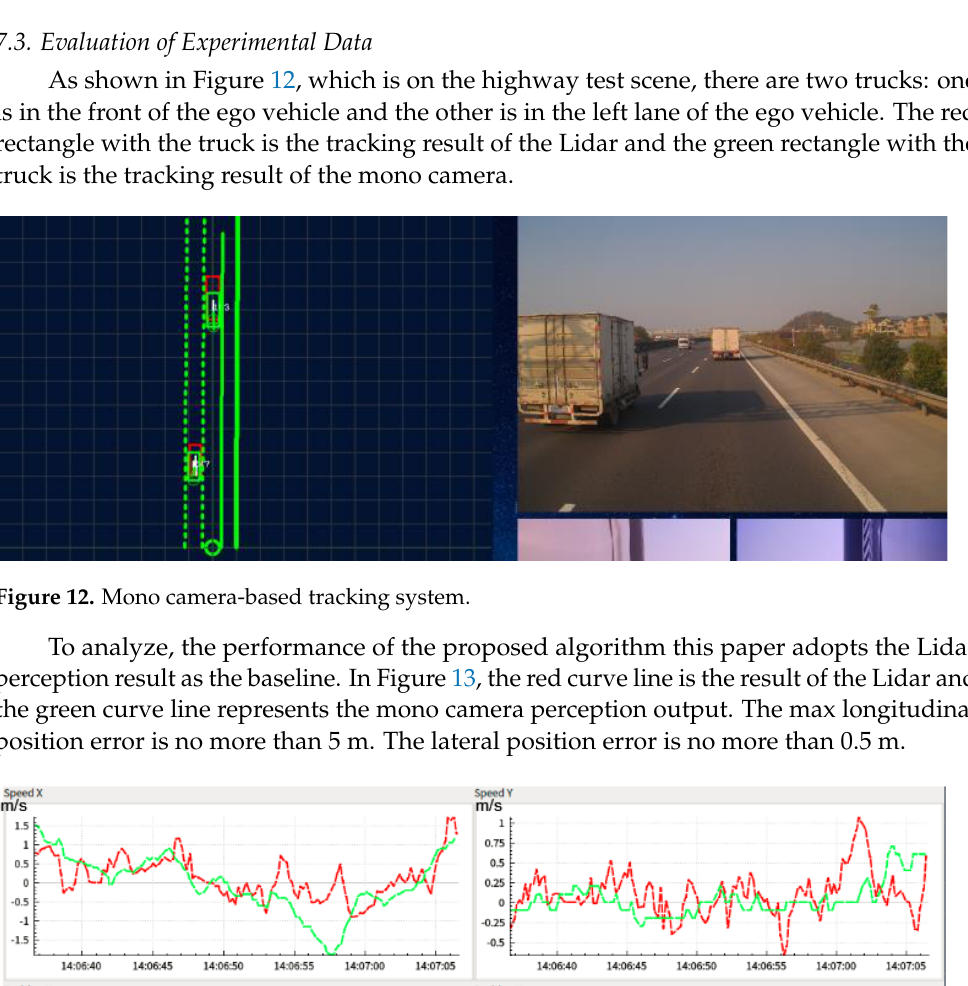
Figure 13. The longitudinal and lateral velocity and position of the target vehicle relative to the ego- vehicle.